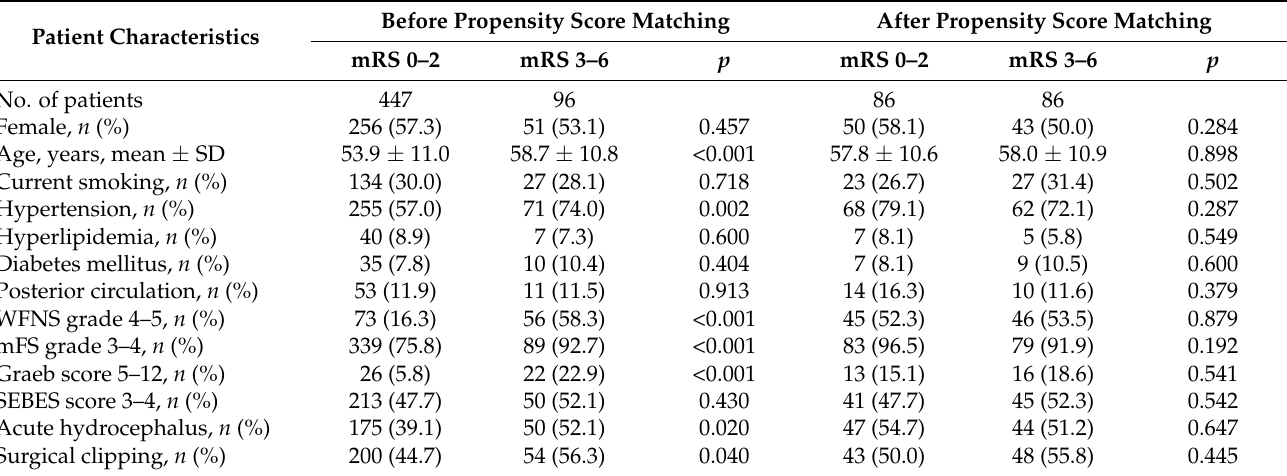
Table 6. Patient characteristics and group comparisons before and after propensity score matching.